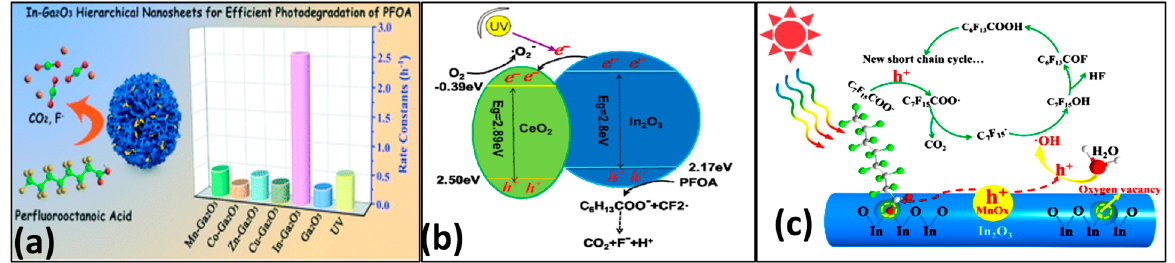
Figure 3. ( a ) Effect of transition metal doping in Ga 2 O 3 hierarchical composites on PFOA degradation (reprinted from [77], copyright (2020) with permission from RSC Publishing). Photogenerated charge separation across the heterojunction of a ( b ) In 2 O 3 /Ce 2 O 3 (reprinted from [82], copyright (2016) with permission from RSC Publishing) and ( c ) In 2 O 3 /MnO x composite (reprinted from [83], copyright (2019) with permission from John Wiley and Sons).